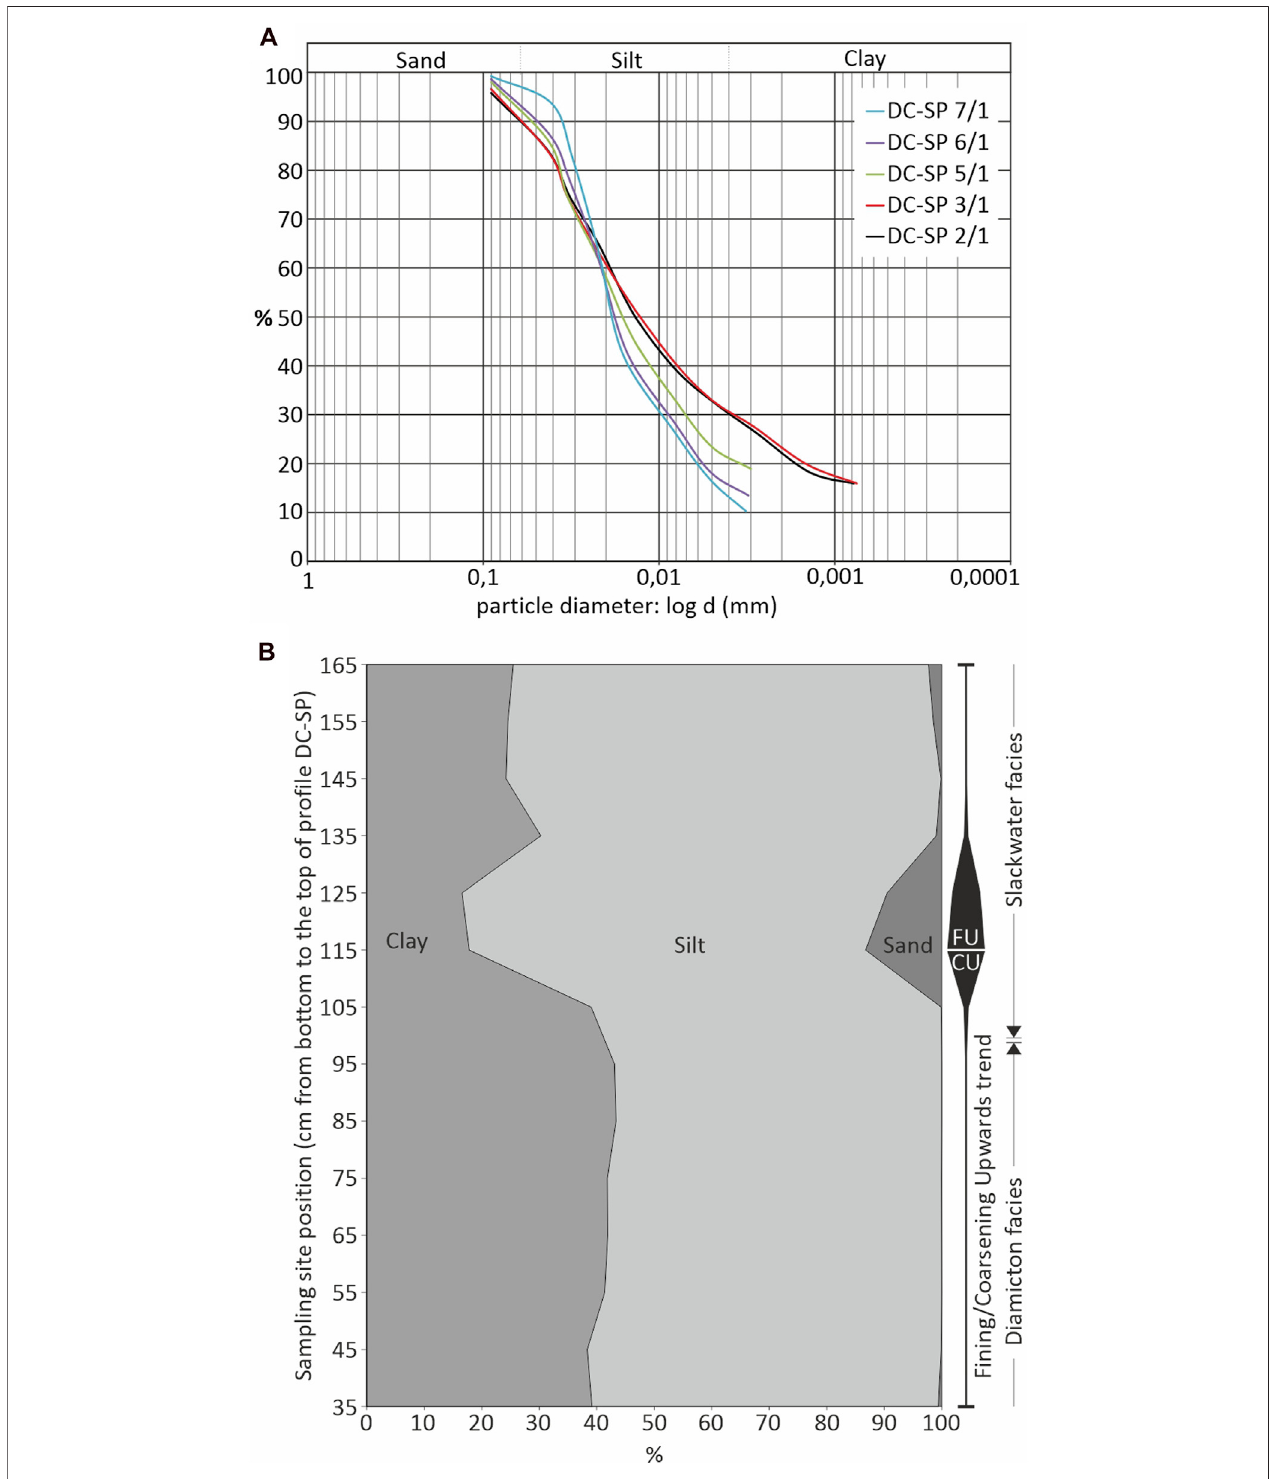
FIGURE4| Granulometriccompositionofsamplesfromthepro fi leDC-SP. (A) Granulometricanalysisbysedimentationmethod:cumulativegranulometriccurves, (B) distribution curves of individual fractions (clay, silt, and sand) through the investigated pro fi le.